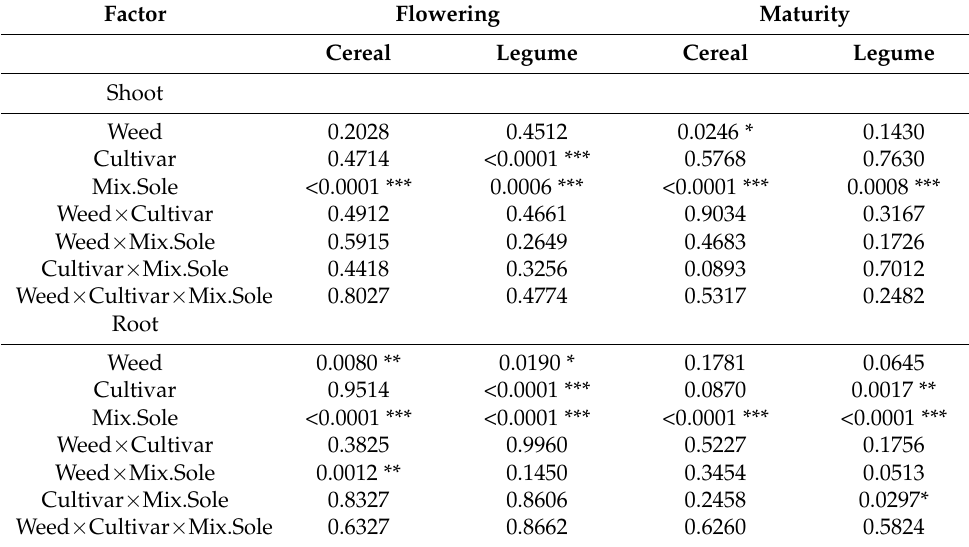
Figure 2. Above and below ground mean plant N pools for different wheat and faba bean cultivars pot-grown as sole crops and in mixtures, and sampled at flowering ( A ) and maturity ( B ). Each cultivar (Ald, ‘Alderon’; Dis, ‘Diskett’; Box, ‘Boxer’; and Fue, ‘Fuego’) was grown as a sole crop and in mixture, with (+) and without ( − ) the weed C. album . Above-ground N pools were calculated from leaves, stems and heads/pods (grains at maturity). Note the different scales in ( A , B ). The error bars represent ± 1SD. Table 1. Analysis of variance for plant nitrogen pools in the shoot and roots of different cultivars of wheat and faba bean grown as sole crops and mixtures sampled at flowering and maturity. Symbols show results with significant levels: *** = p ≤ 0.001; ** = p ≤ 0.01; * = p ≤ 0.05.